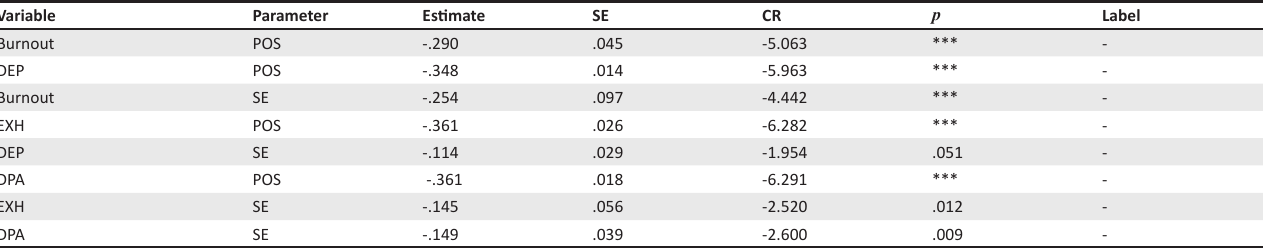
TABLE 3: Results of structural equation modelling (SEM) estimates ( n = 268).